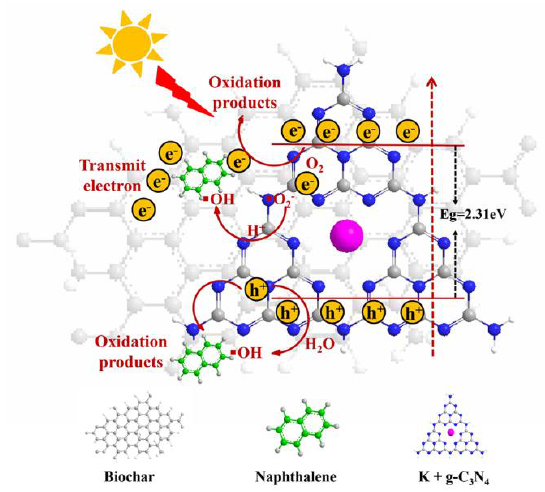
Figure 9. Schematic diagram of a photogenerated charge transfer in the biochar-supported K-doped g-C 3 N 4 system under visible light irradiation.